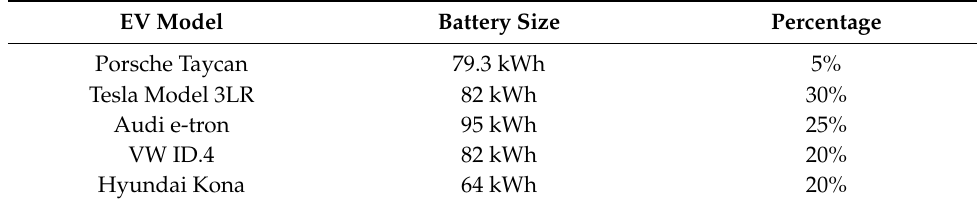
Table 2. Battery Size and Percentage of EV